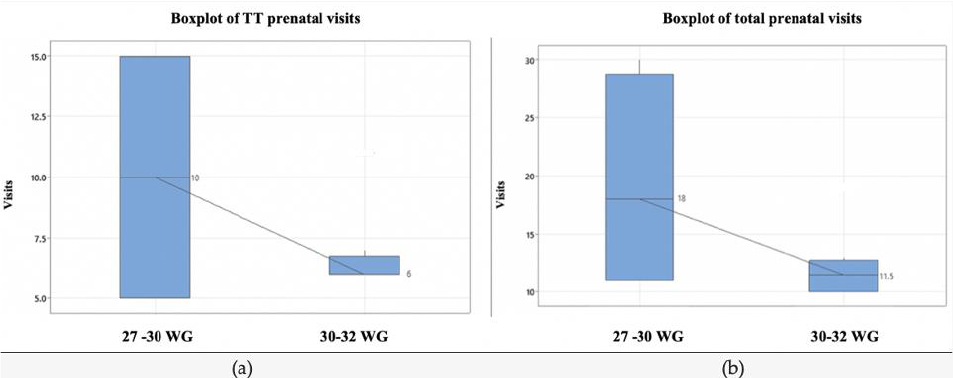
Figure 3. ( a ) The boxplot of TT prenatal visits; ( b ) The boxplot of total number of scheduled medical appointments. Abbreviations: WG weeks’ gestation, TT—third trimester.